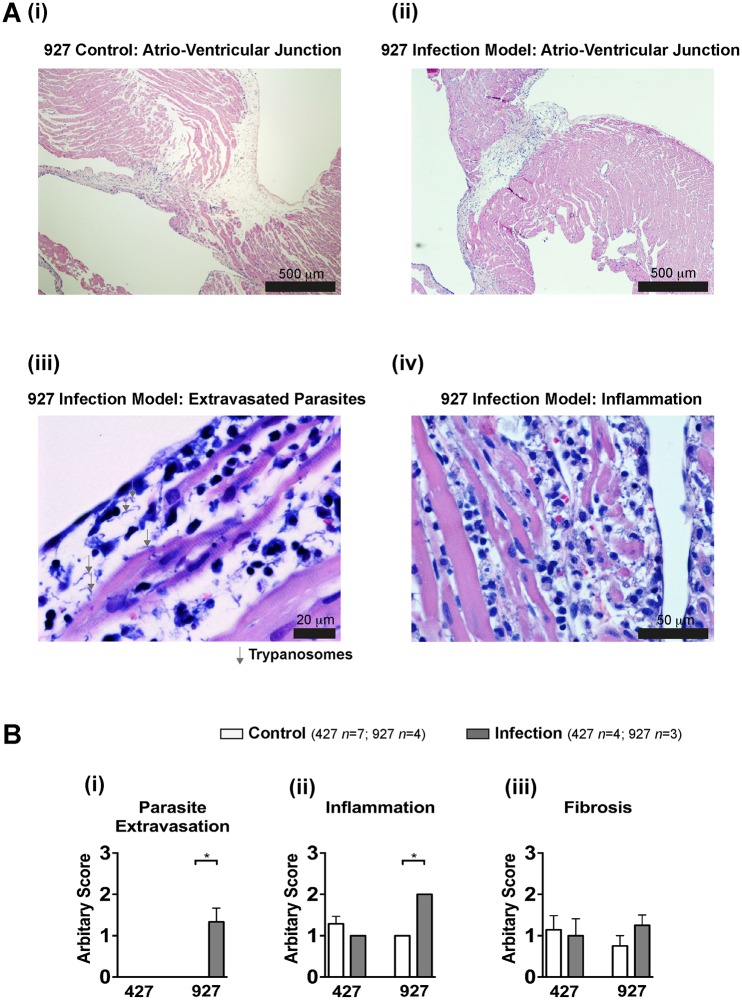
Histology of infected hearts.A) Atrio-ventricular region from (i) control and (ii) TREU 927 infected hearts (H&E). Higher magnification demonstrating (iii) parasite extravasation (Giemsa) and (iv) inflammation (H&E). B) Mean ± SEM of semi-quantitative pathological scoring (0–3; see methods) for: (i) parasite extravasation, (ii) inflammation and (iii) fibrosis.